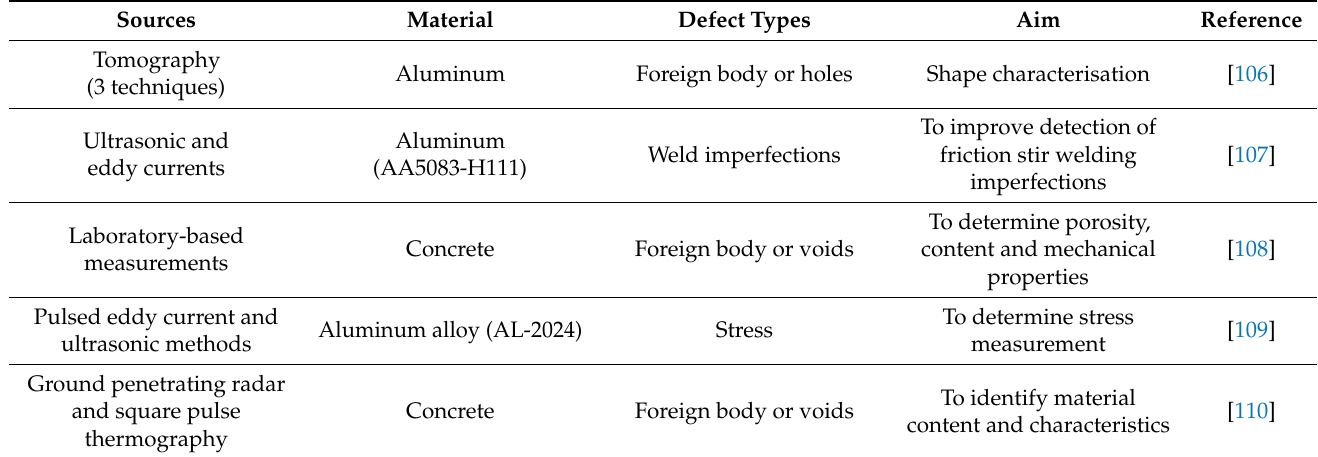
Table 7. A summary of fuzzy set-based fusion approaches for NDT